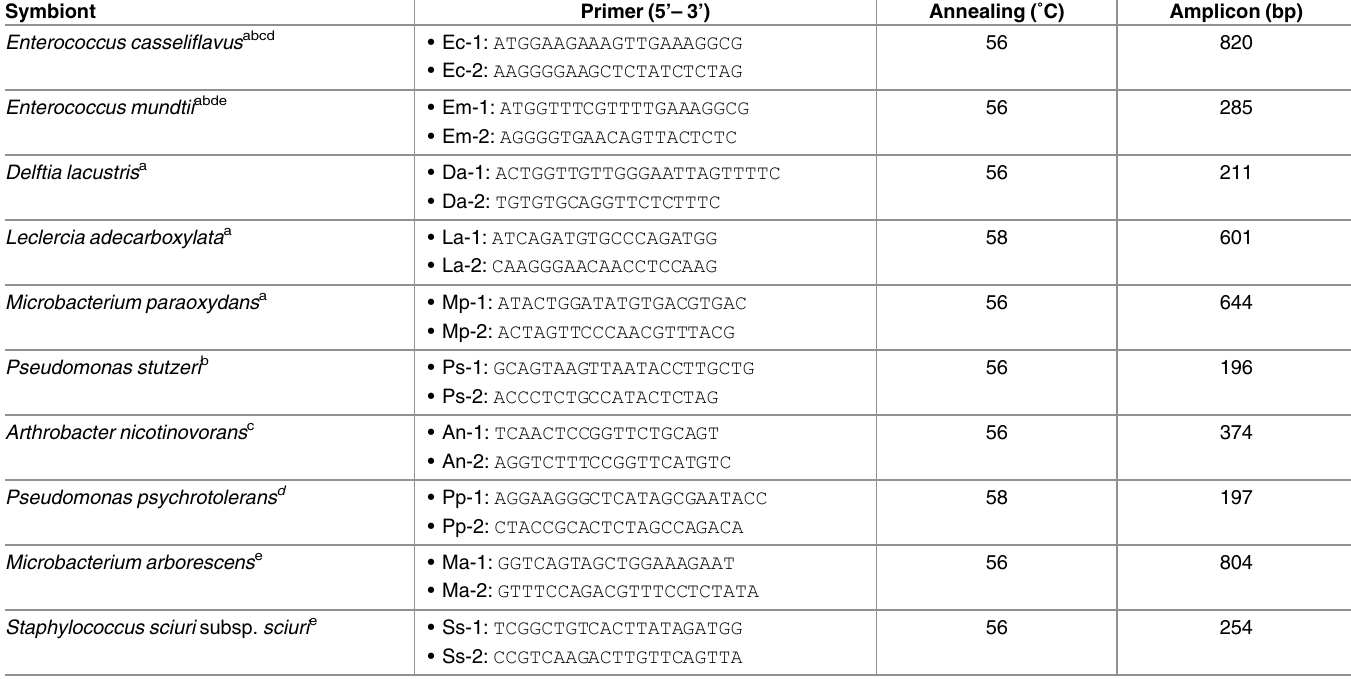
Table 1. Species-specific primersets,annealing temperature and expectedamplicon size (pb) used in diagnostic-PCR amplifications for detection of gut microbes isolated from resistant larvae of Spodoptera frugiperda in the gut of a susceptible